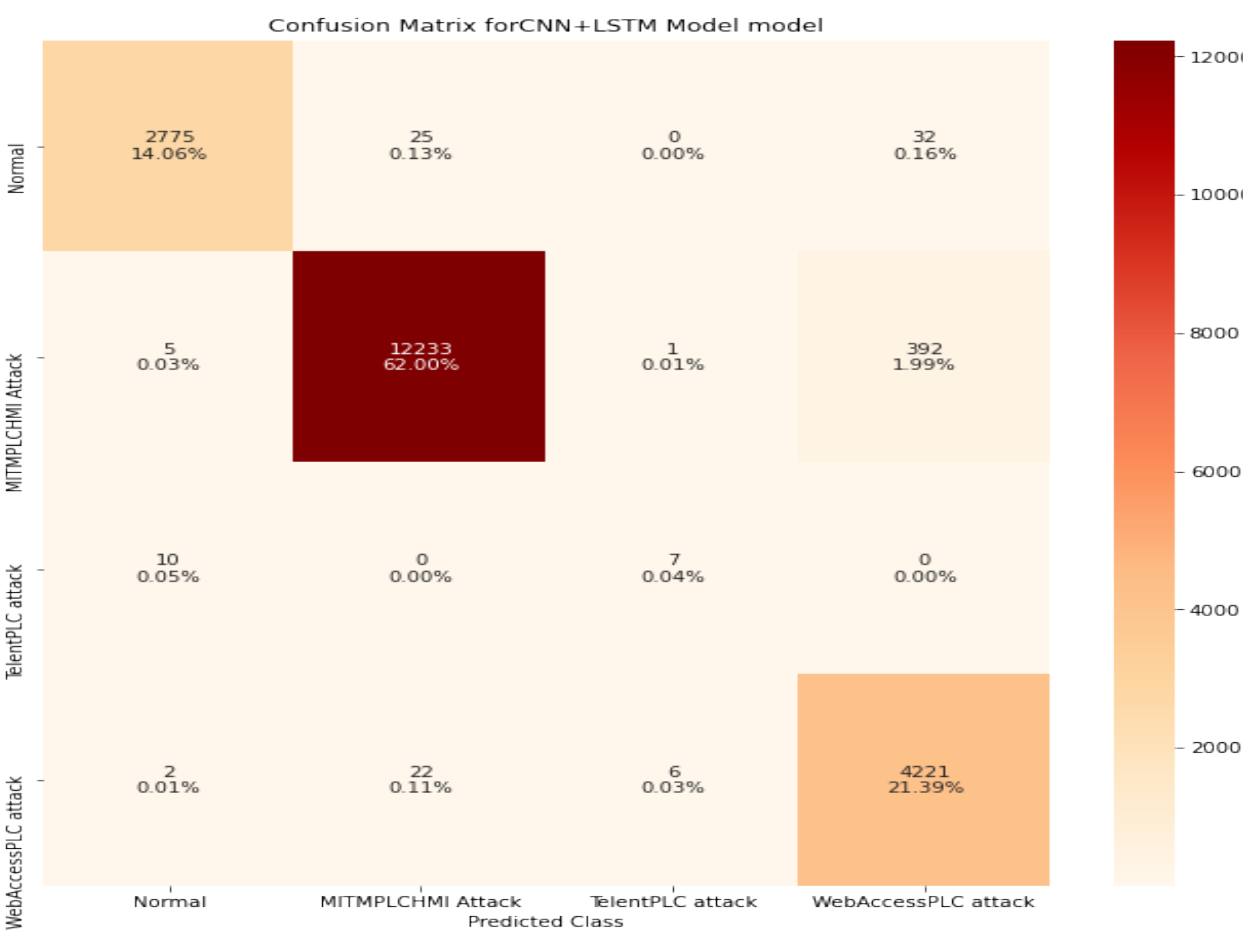
Figure 11. Confusion metrics of the CNN-LSTM model using the multiclass classification dataset.